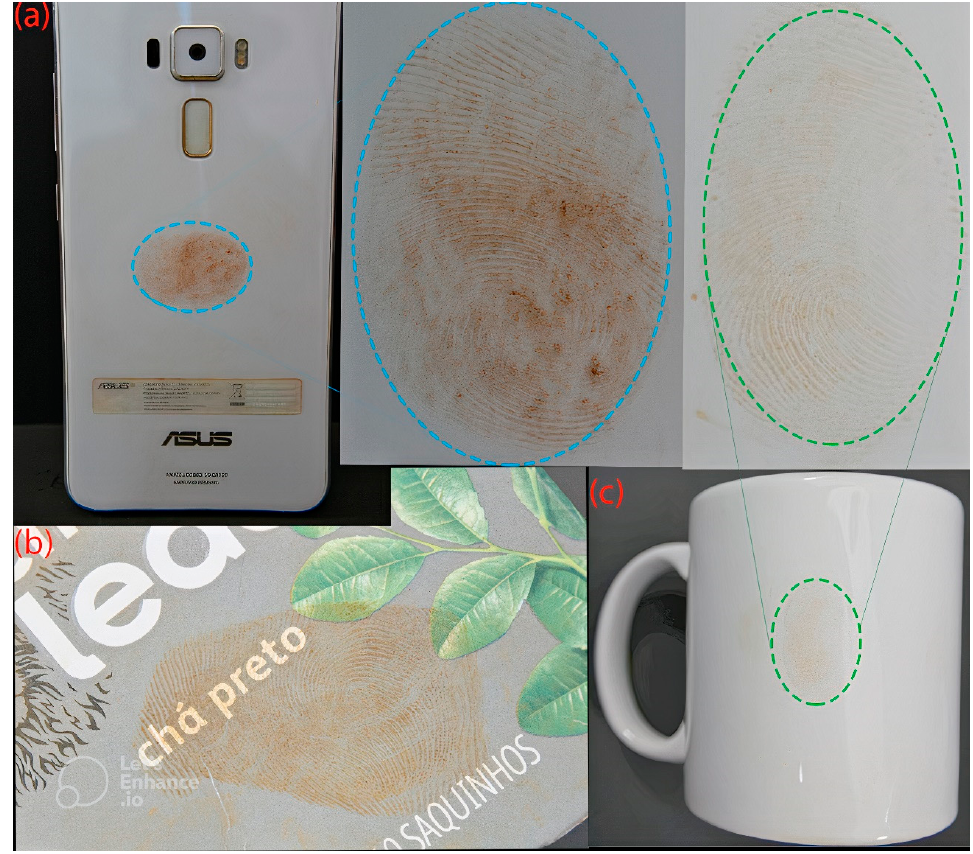
Figure 3. Fingermarks developed with RHL/chalcone on objects, such as ( a ) cell phone (glass); ( b ) box (cardboard); ( c ) mug (ceramic).